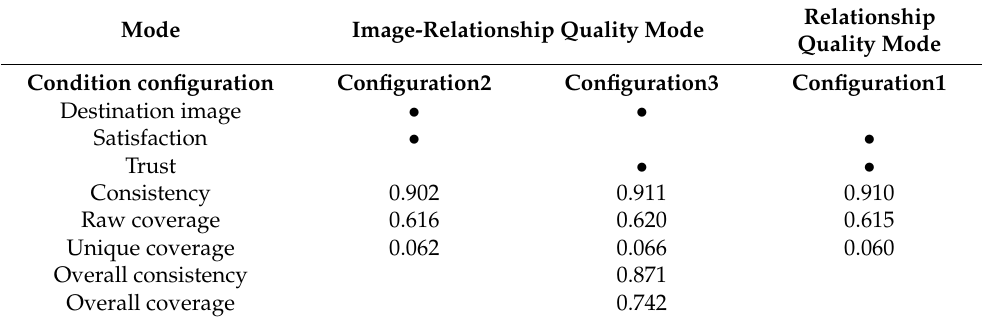
Table 11. Configuration analysis of high-level private pro-environmental